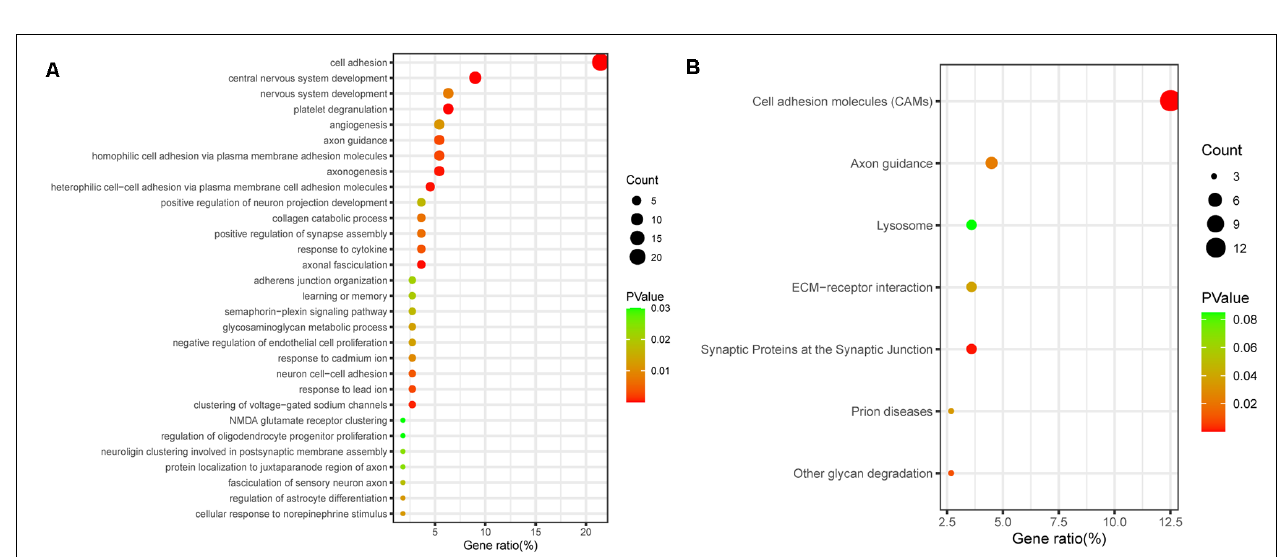
FIGURE 2 | Bioinformatic analysis of all differentially expressed proteins. (A) GO analysis of proteomic data. The bubbles represent the top 30 biological processes related to cognitive dysfunction, p < 0.05. (B) KEGG analysis of proteomic data. The bubbles represent the seven enriched pathways, indicating their enrichment scores, gene counts, and p